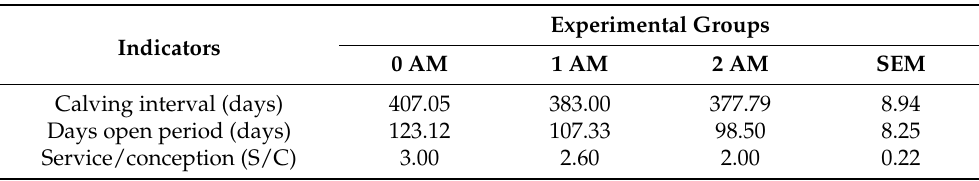
Table 8. Reproductive parameters of Ayrshire lactating cows fed Agro-Matic protein concentrate at different levels.